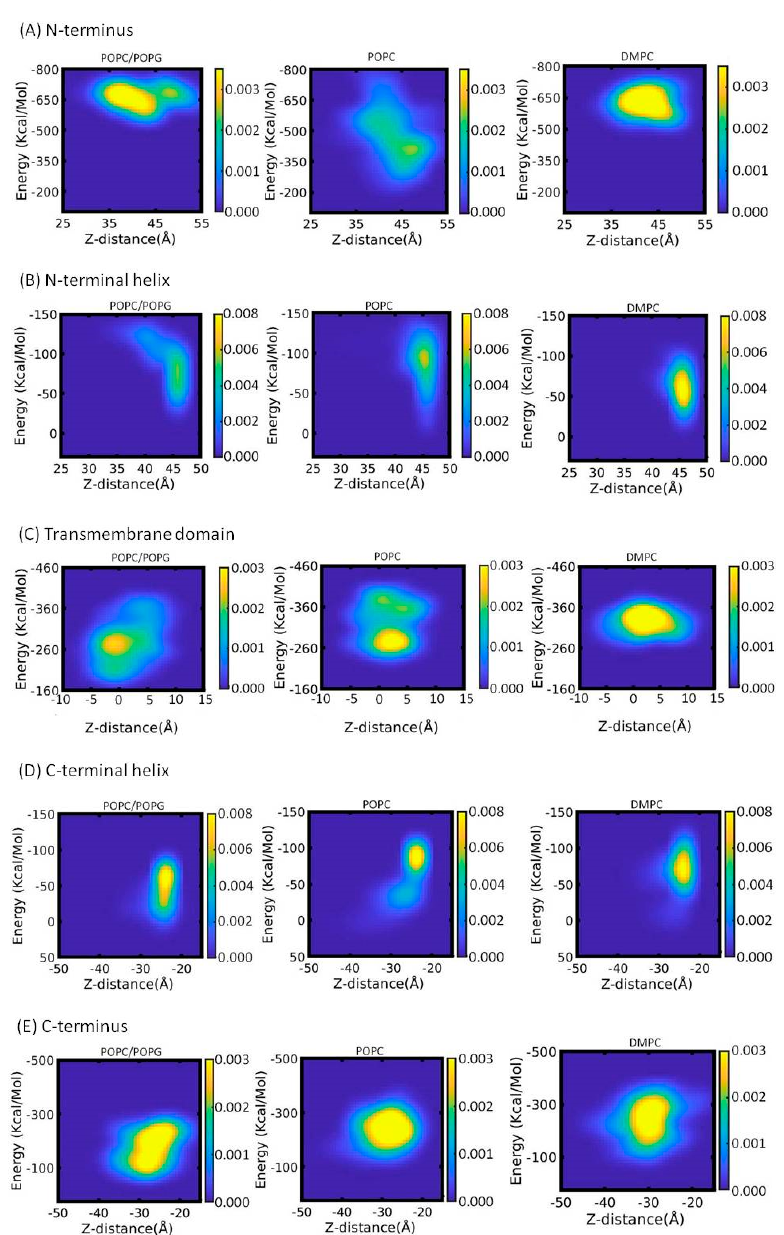
Figure 10. Probability density plot of total interaction energy of N ‐ terminus ( A ), N ‐ terminal helix ( B ), Transmembrane domain ( C ), C ‐ terminal helix ( D ) and C ‐ terminus ( E ) of KCNE3 with lipid bilayers against corresponding Z ‐ distances from the center of mass of the lipid bilayers for different lipid bilayer membranes. The yellow color indicates the highest probability and blue color represents the lowest